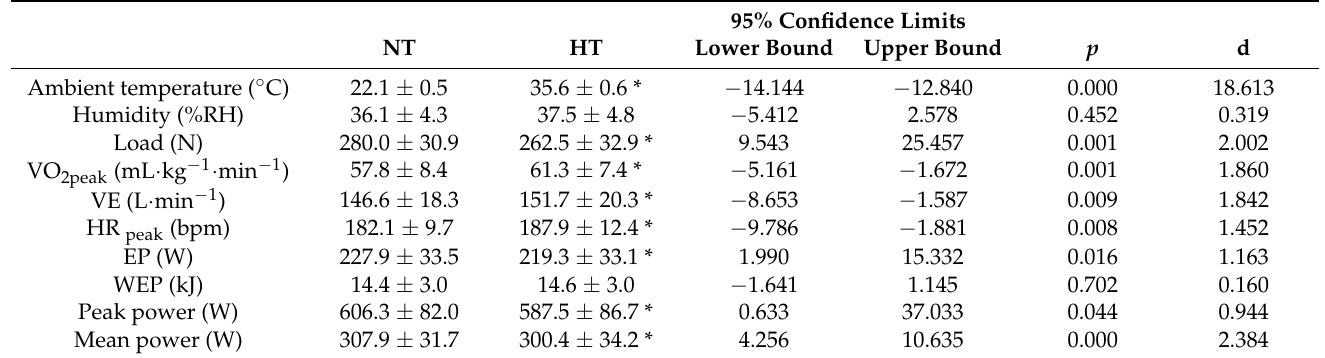
Table 2. Effect of different environmental temperatures on 3-min all-out tests.